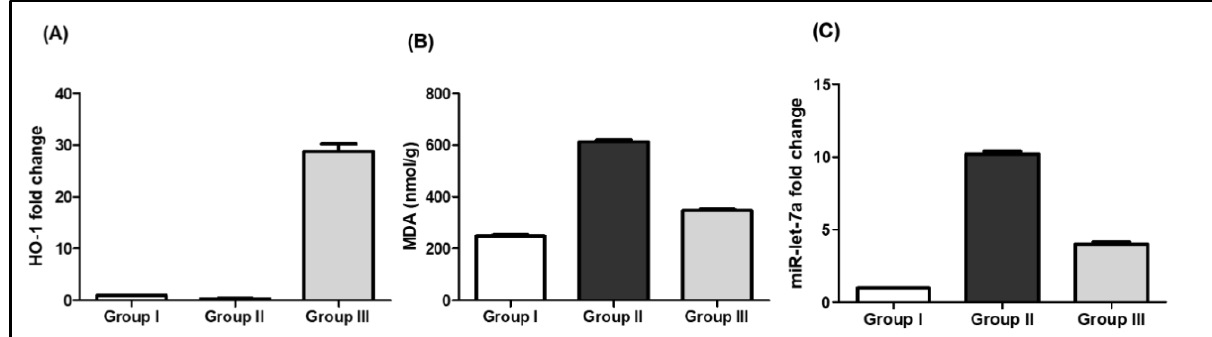
Figure 10. Levels of the studied markers in the lung tissues of the different groups ( A ) Relative expression of HO-1 mRNA. ( B ) MDA levels. ( C ) Relative expression of miR-let-7a. Data are expressed as mean ± SD.